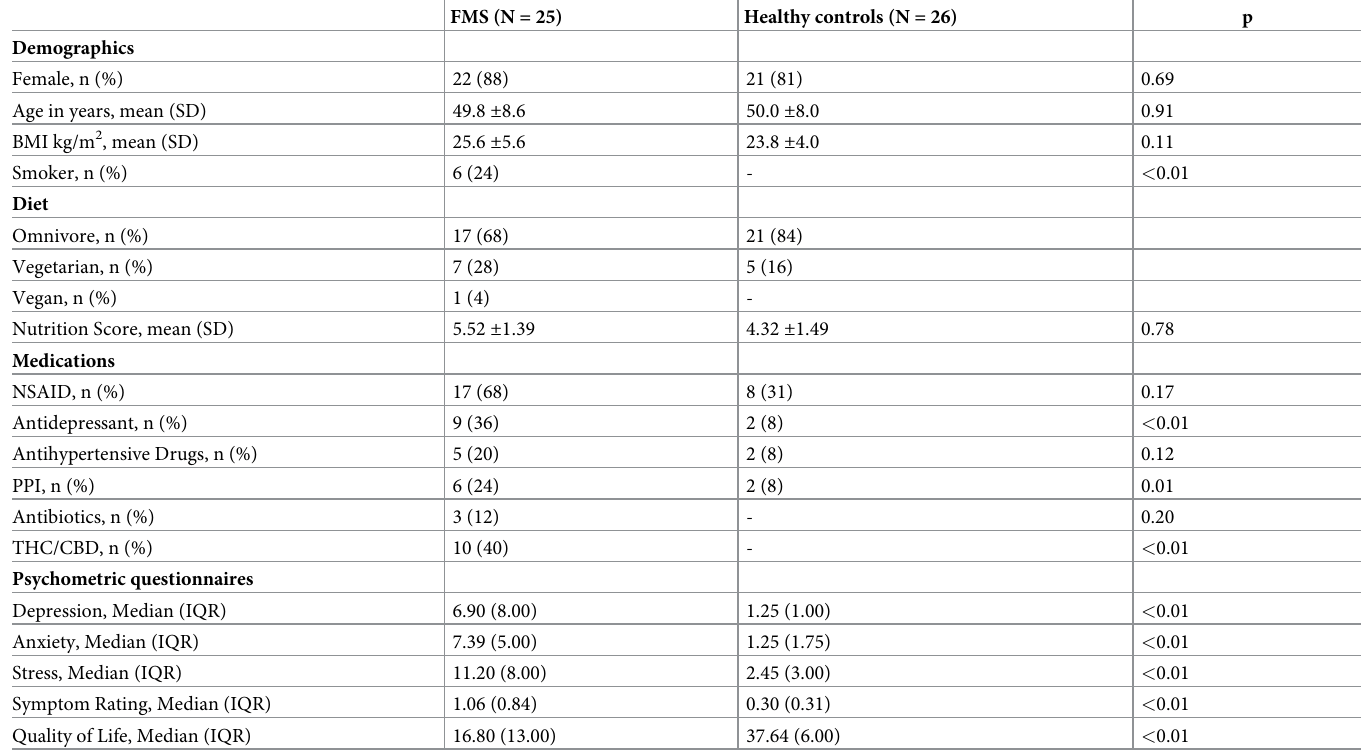
Table 1. Demographic data (age, sex, BMI, smoking status) and dietary, medication and psychometric profiles of patients with FMS vs healthy